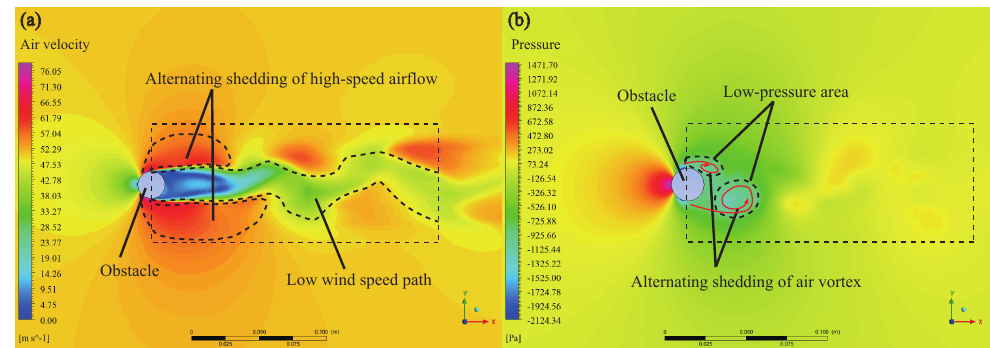
Figure 13. Air velocity and pressure behind the obstacle. ( a ) the airflow behind the obstacle has relatively low velocity and sheds alternately from both sides after encountering the obstacle, forming a classical Karman vortex street; ( b ) the alternate shedding of air vortices creates alternating high and low-pressure paths with specific wavelengths and